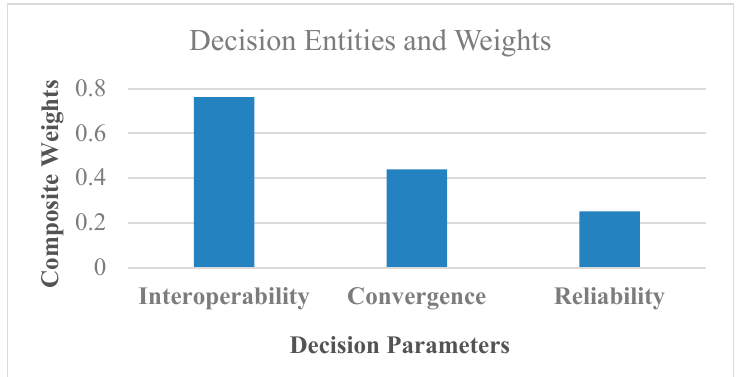
Figure 6. Performance analysis of CPS in connected healthcare.